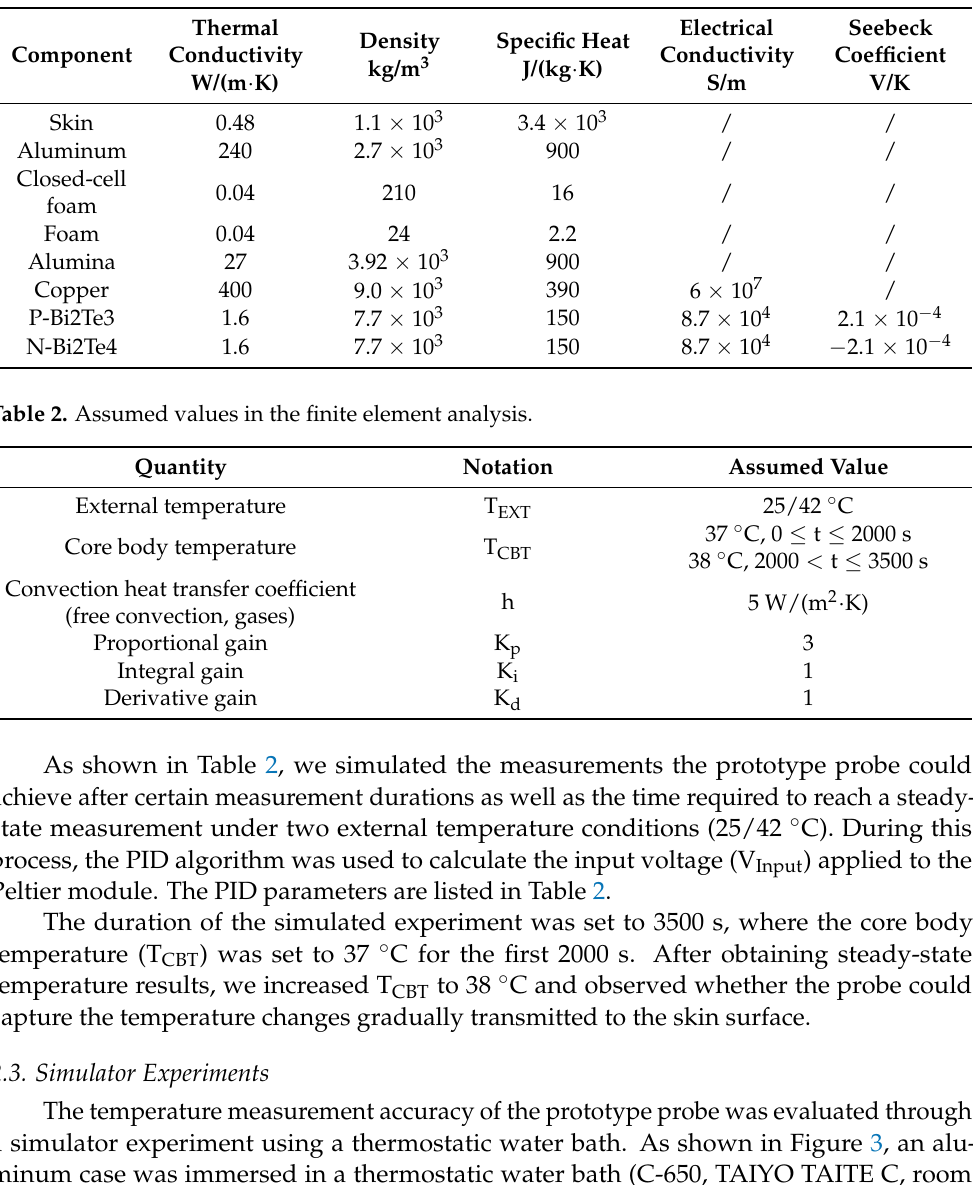
Table 1. Assumed values of the probe materials.